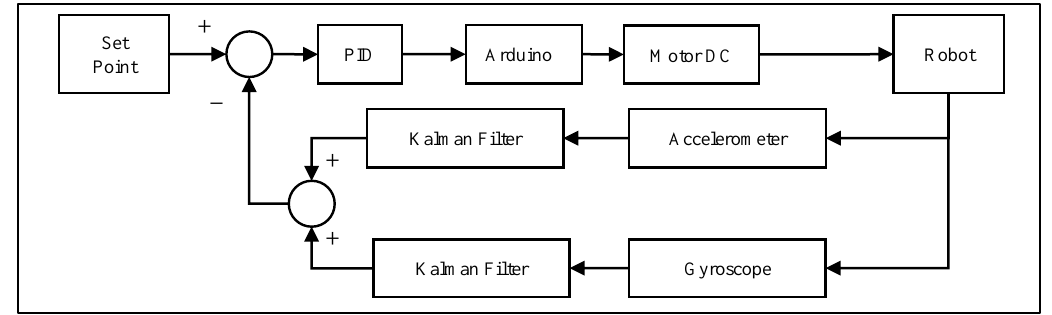
Figure 8. Design of the proposed disturbance rejection control